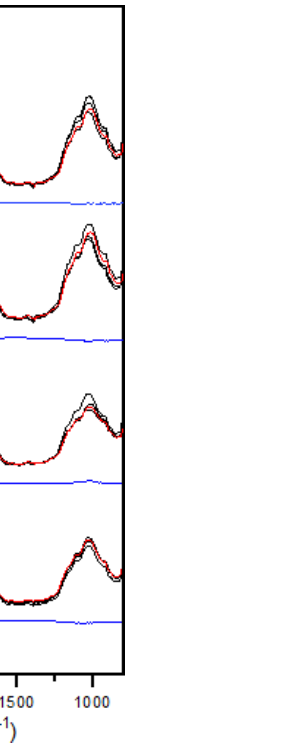
Figure A6. Example DRIFT spectra showing three replicate spectra, the mean spectra, and the residual spectra for 1993 and 2008 samples.